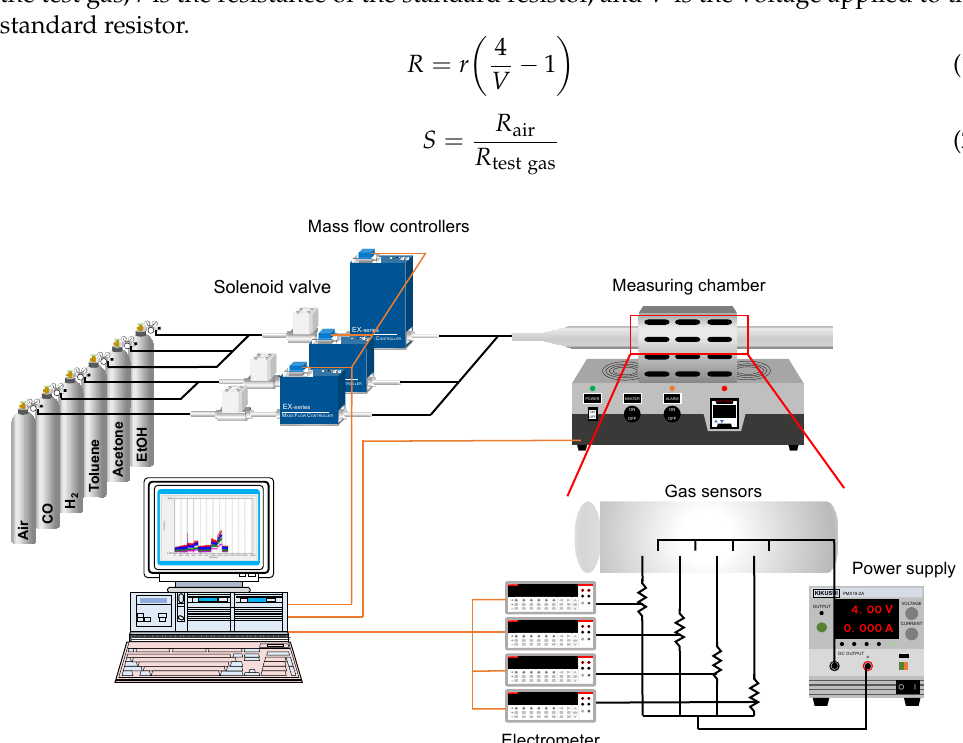
Figure 1. Schematics of the experimental setup for gas sensing measurements.